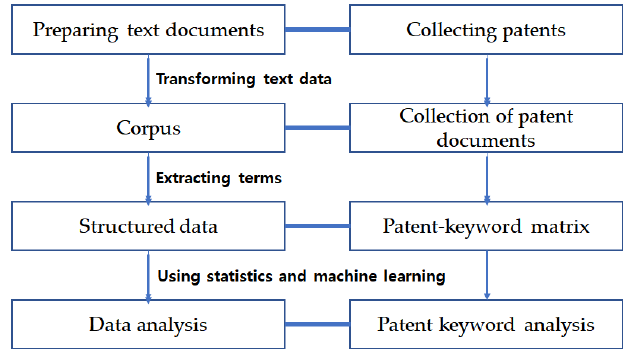
Figure 2. Patent data preprocessing and analysis.